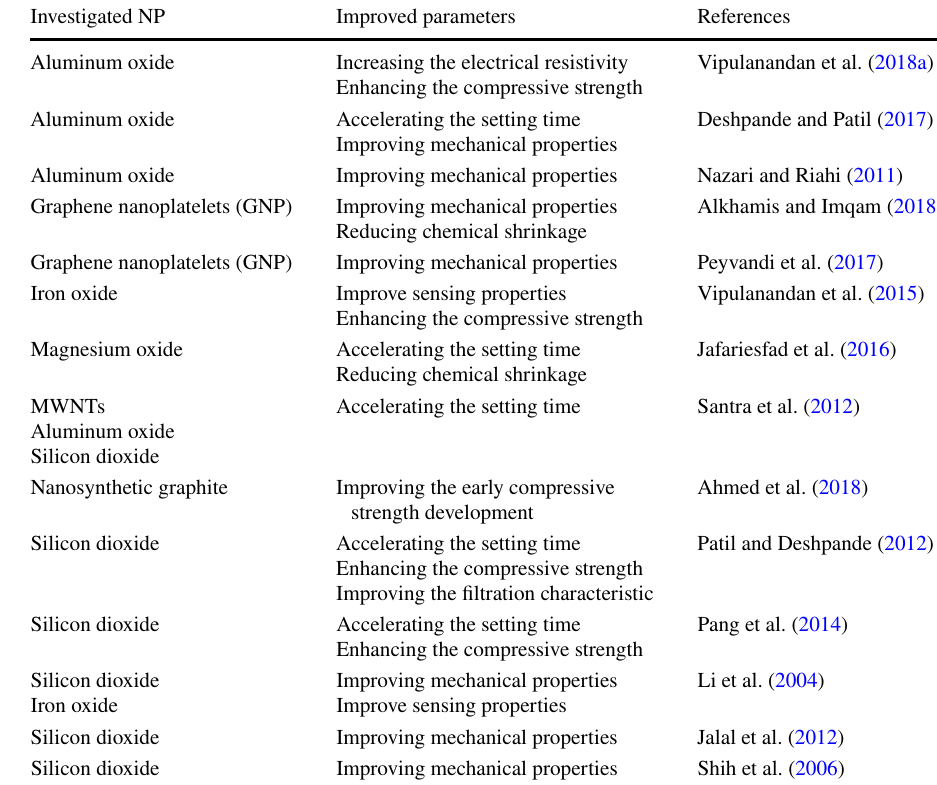
nanoparticles for